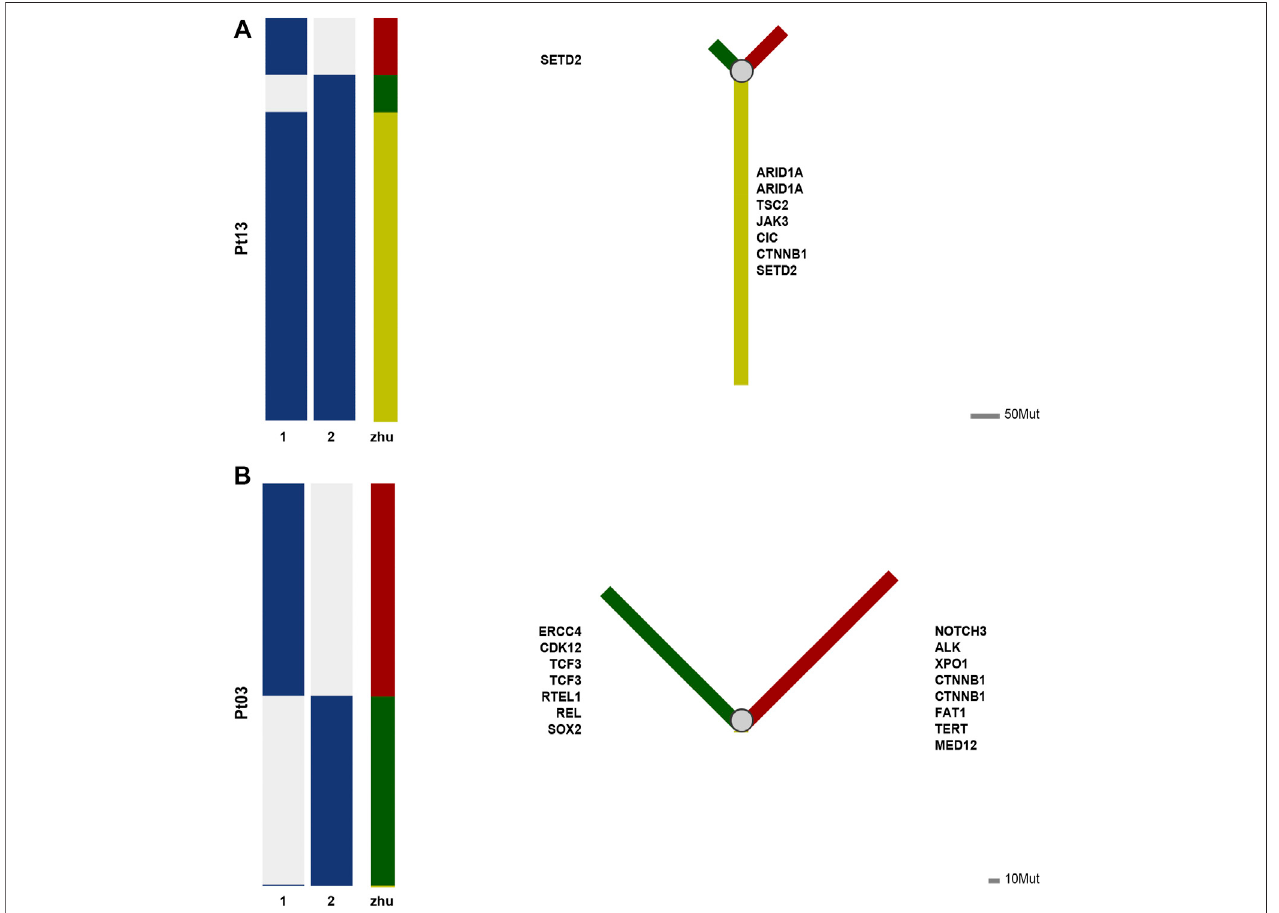
FIGURE 3 | (A) Phylogenetic tree of patient Pt13. (B) Phylogenetic tree of patient